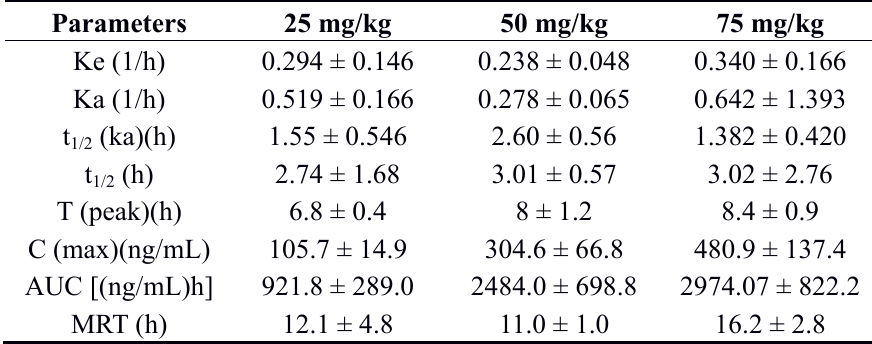
Table 19. Pharmacokinetic parameters of TA-III after intragastrical administration to rats at different